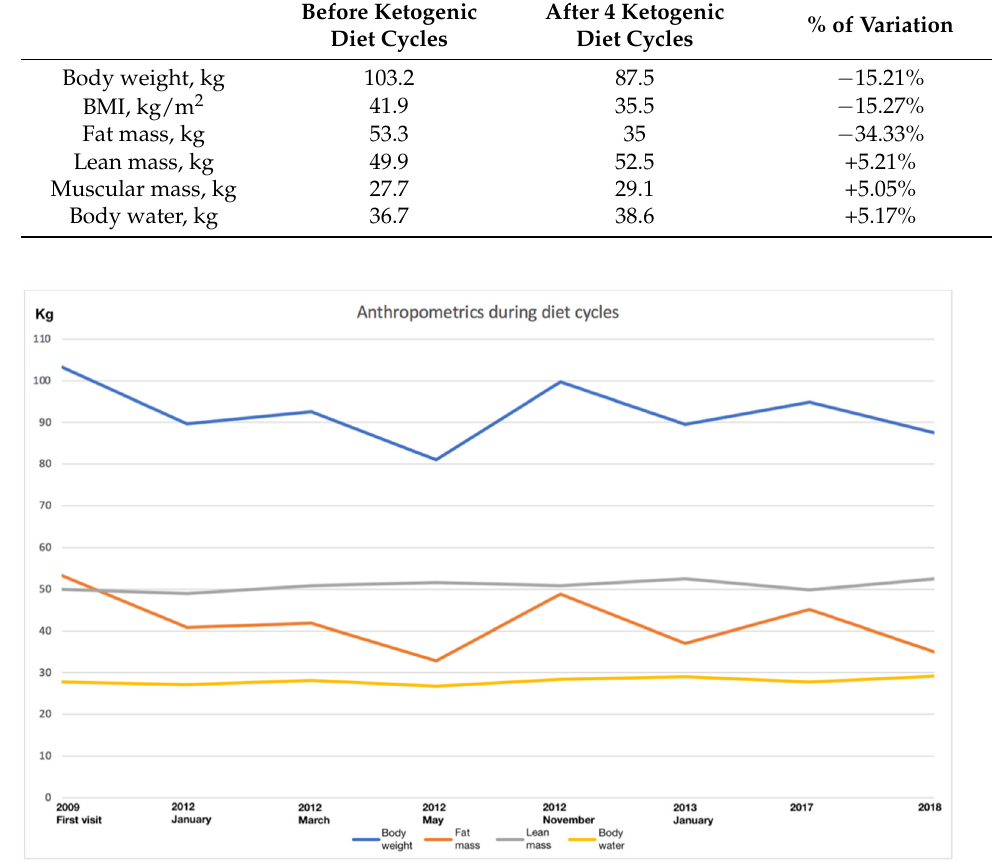
Figure 2. Anthropometrics and bioelectrical impedance variables during the diet cycles.